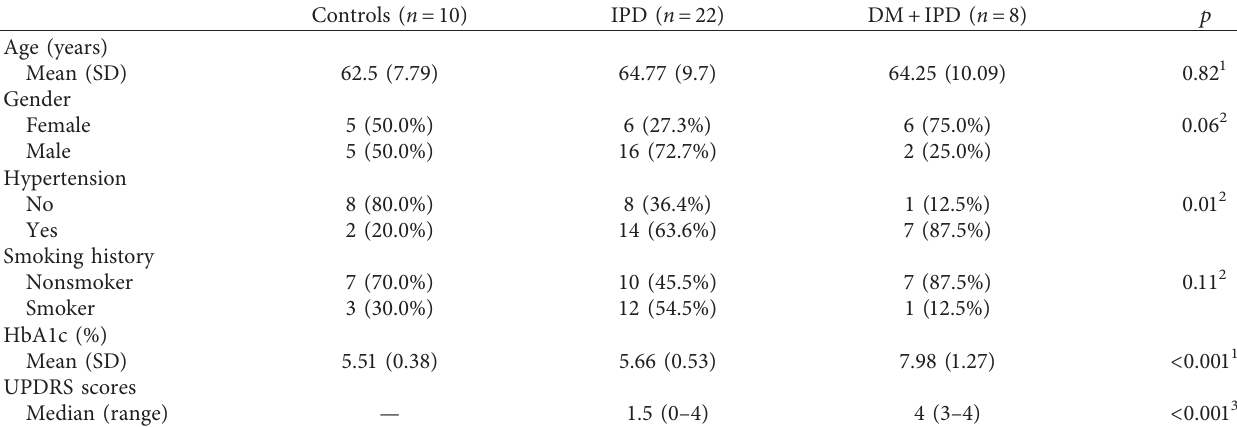
Table 2: Demographic data of the IPD study subjects with/without DM versus the control